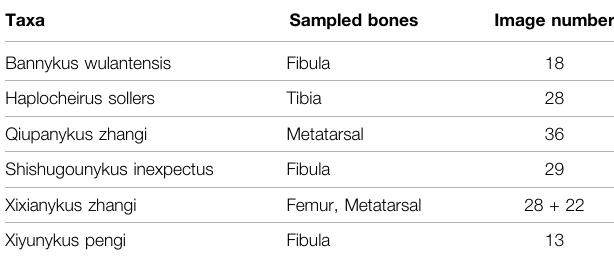
TABLE 1 | Sampled Alvarezsaurian dinosaur bone thin